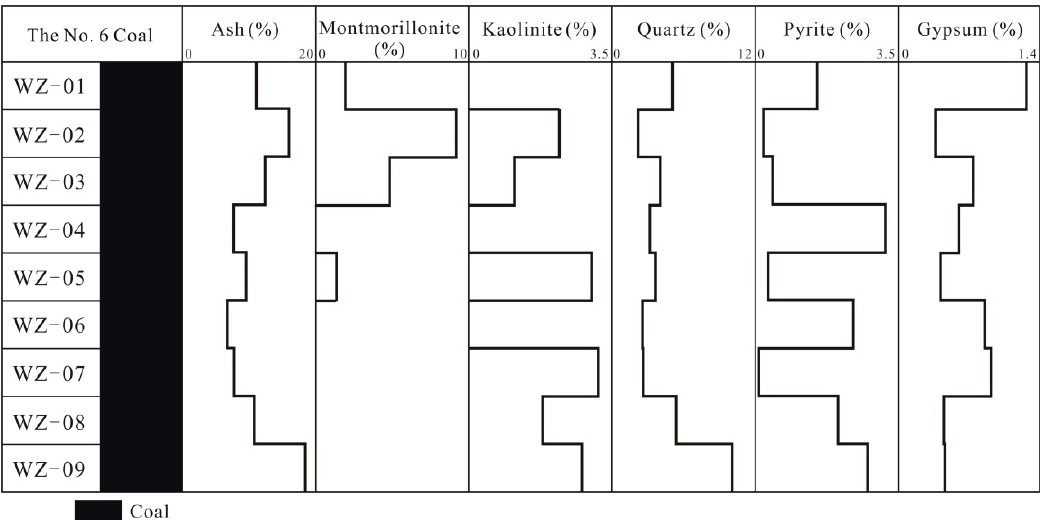
Figure 5. Vertical variations of ash yield and minerals through the No.6 Coal section (wt. %).